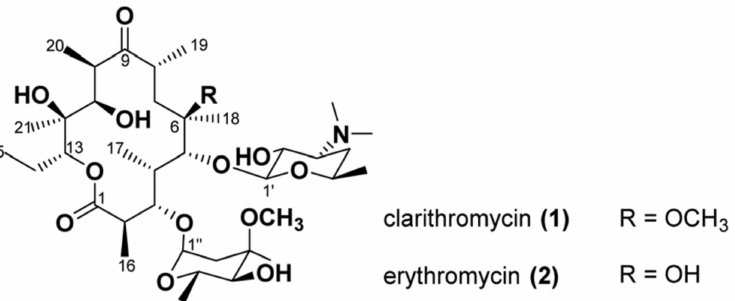
Figure 5. Chemical structures of clarithromycin and erythromycin. Reprinted with permission from ref. [45]. Copyright 2020 Royal Society of